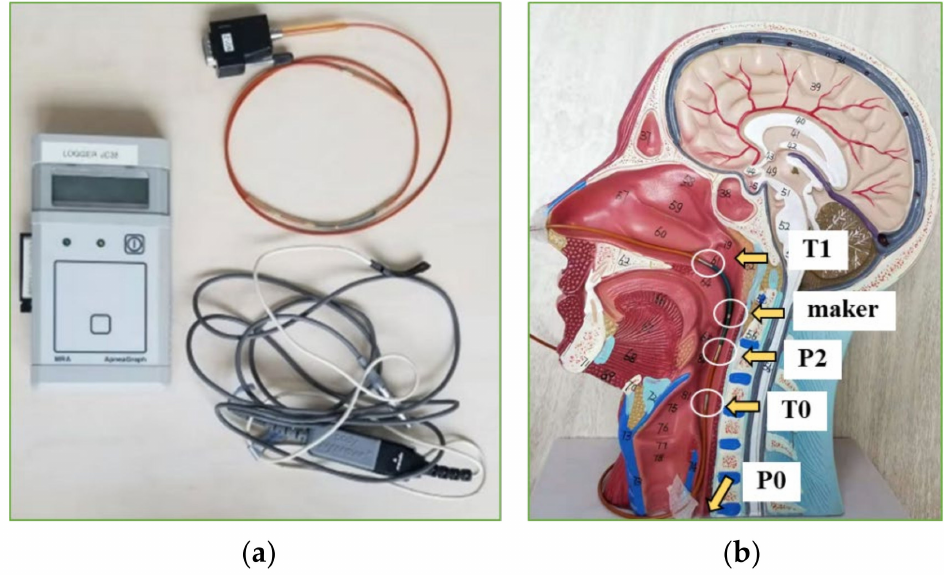
Figure 4. Airway pressure fluctuation monitoring (taken in the Sleep-Disordered Breathing Center, the Sixth Affiliated Hospital of Sun Yat-sen University). ( a ) ApneaGraph AG 200; ( b ) schematic diagram of upper airway pressure